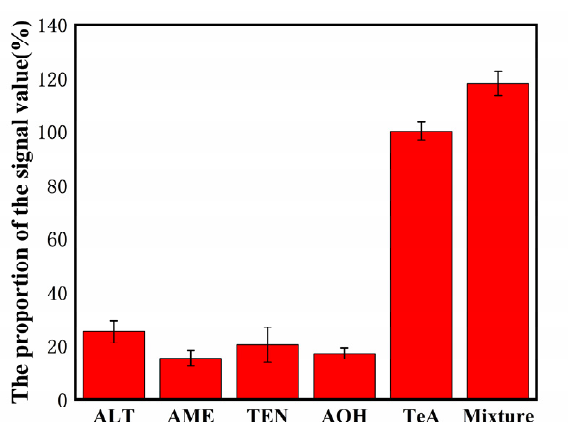
Figure 6. Selectivity of the biosensor detection of TeA (500 pg/mL) against the interference proteins: 50 ng/mL ALT, 50 ng/mL AME, 50 ng/mL TEN, and 50 ng/mL AOH.